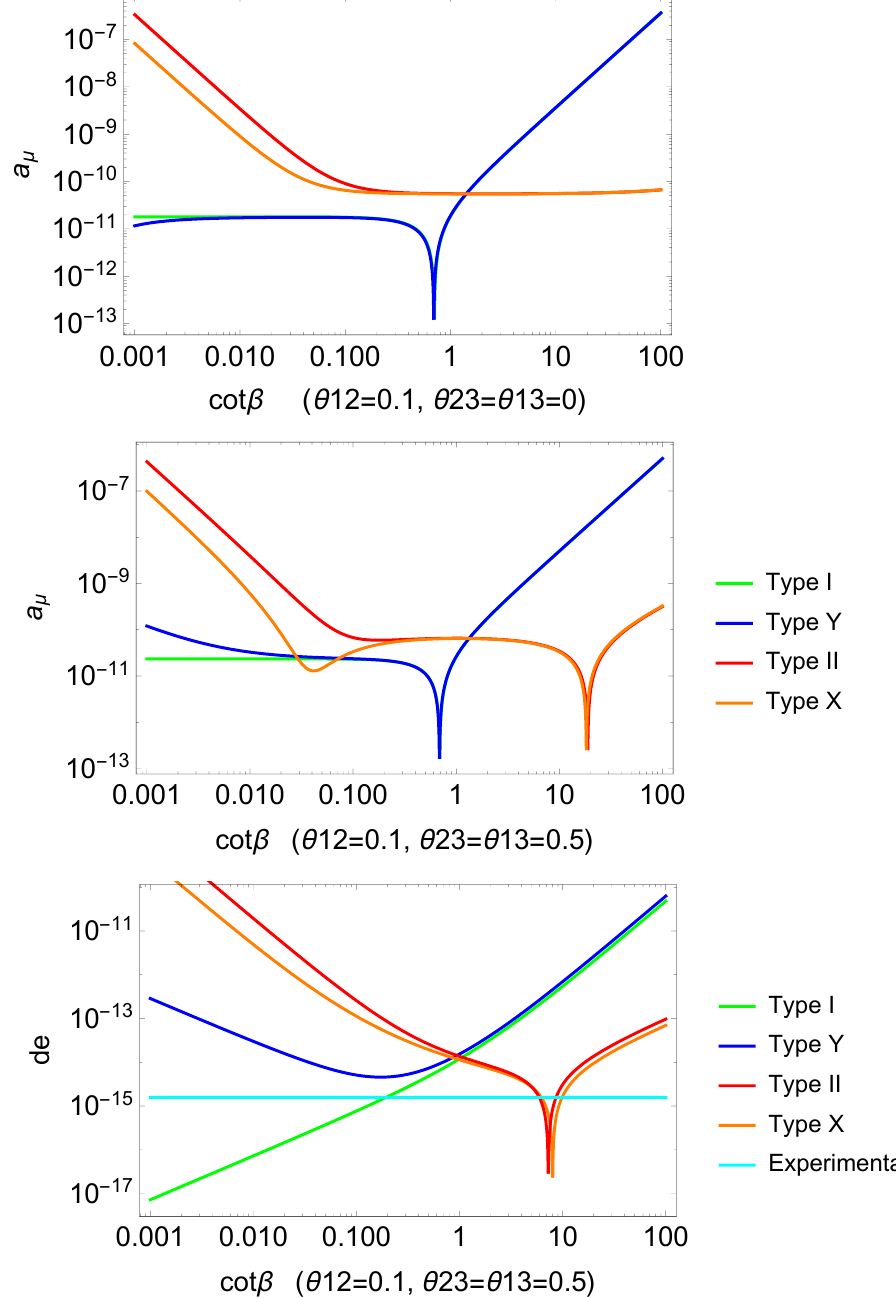
Figure 9 . a (cid:22) (top) and d e (bottom) values in di(cid:11)erent 2HDM Types for (cid:12)xed values of angles and masses ( m h = 145 ; 105 2 ; 3